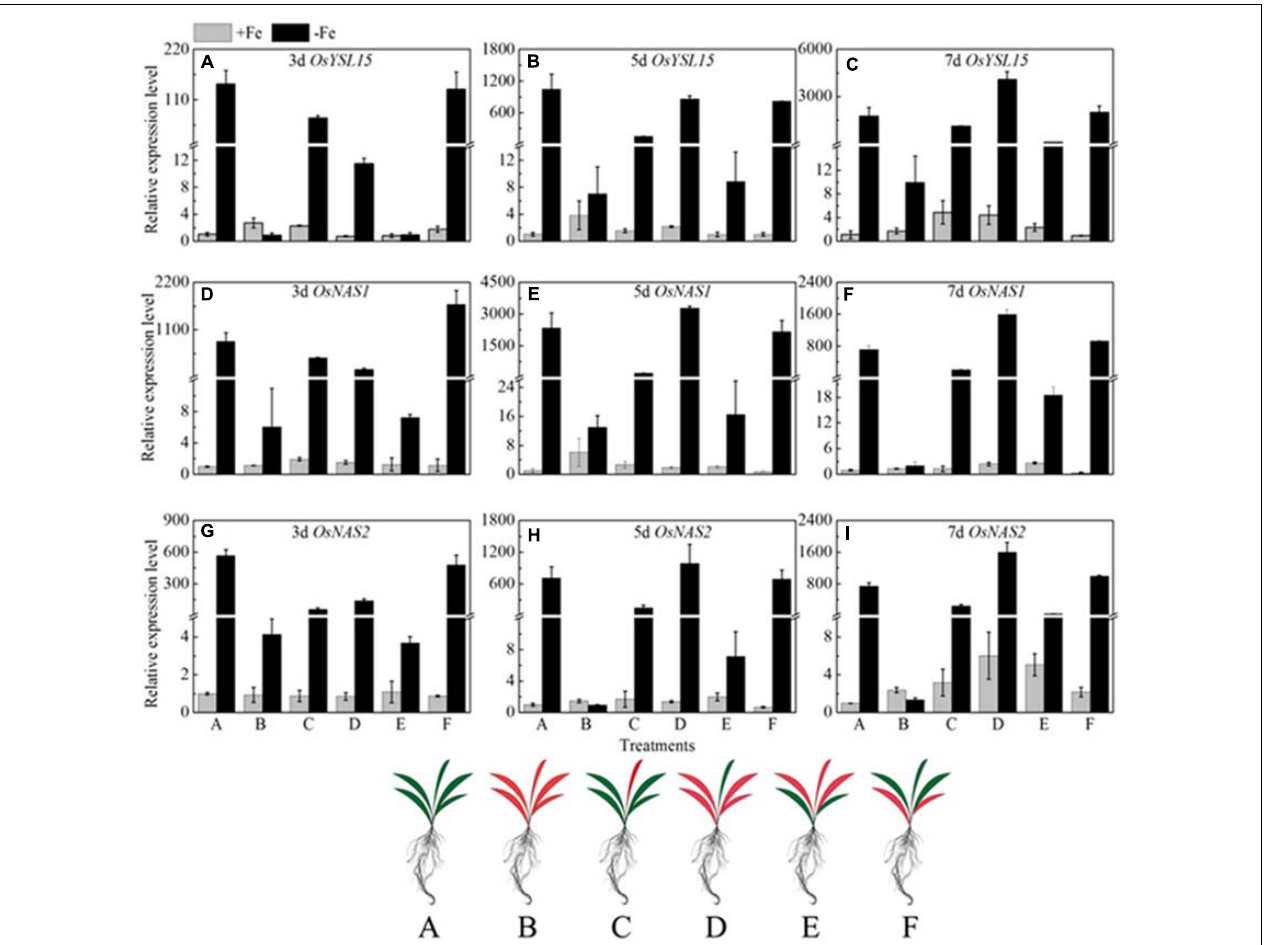
FIGURE 10 | Effects of shoot excision on expression levels of OsYSL15, OsNAS1 and OsNAS2 in root in Yang 6. qRT-PCR analysis of genes in Yang 6 roots ( n = 3, mean values with SD). The part labels in figures indicate the expression levels of different genes after different days of iron deficiency treatment. (A–C) Expression levels of OsYSL15 at 3, 5, and 7 days; (D–F) Expression levels of OsNAS1 at 3, 5, and 7 days; (G–I) Expression levels of OsNAS2 at 3, 5, and 7 days. The value obtained from the control plant (A) with sufficient iron was arbitrarily set at 1.0. A, all leaves; B, all leaves removed; C, all mature leaves removed, with the fresh leaf intact; D, removed all the leaves besides of the fresh leaf; E, the upper functional leaves removed; F, the oldest leaves